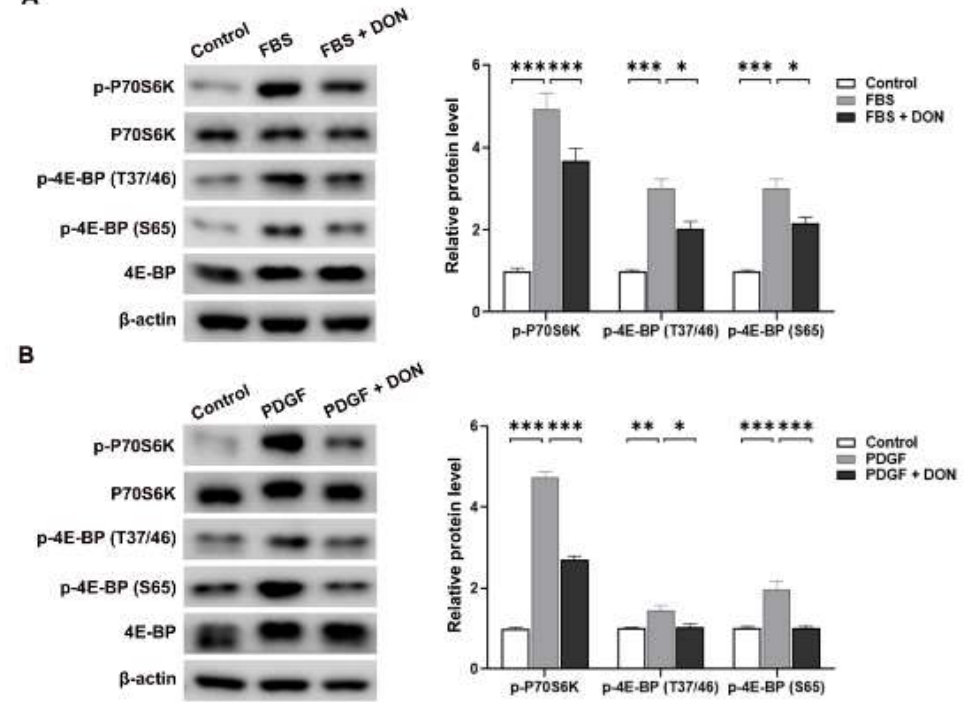
Figure 2. DON attenuates mTORC1 activity in growth factor-stimulated VSMCs. ( A ) and ( B ) Representative western blots showing the effects of DON on the levels of p-p70S6K, p-70S6K, 4E-BP, p-4E-BP (Thr37/46), and p-4E-BP (Ser65) in VSMCs stimulated with FBS ( A ) and PDGF ( B ). Data are expressed as the mean ± SEM ( n = 3 technical replicates). * p < 0.05, ** p < 0.01, and *** p < 0.001.